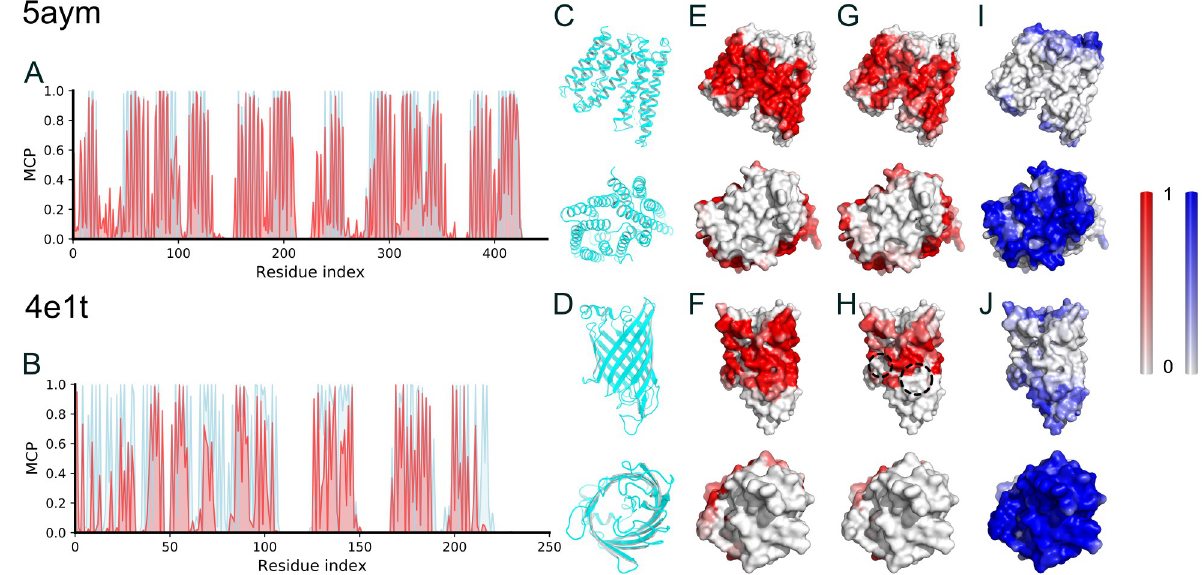
Fig 2. Membrane contact probability (MCP) of two representative membrane proteins. (A-B) Comparison between the MD observation (cyan) and the prediction (red) of the MCPs. (C-D), Side and top views of the two representative proteins. (E-F), The outer surface of the representative membrane proteins, colored according to the MCP values obtained from MD simulations. (G-H), Similar to (E-F), but colored according to the predicted MCP values. (I-J), Similar to (E-F), but colored according to the predicted SA values by RaptorX. The PDB ID of the α -helix membrane protein was 5aym [39], representing a crystal structure of a bacterial homologue of iron transporter ferroportin in the outward-facing state with soaked iron with more than 10 transmembrane helices and 440 residues. The PDB ID of the β -sheet membrane protein was 4e1t [40], an X-ray crystal structure of the transmembrane beta-domain from invasion from Yersinia pseudotuberculosis with 245 residues.